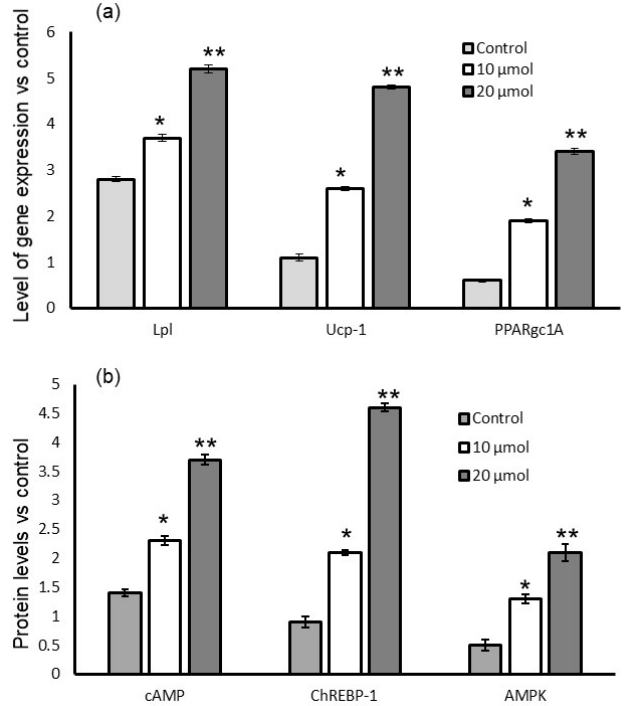
Figure 8. Effect of lut-7 -O- rutinoside on mRNA expression levels of Lpl, Ucp-1, and PPARGC-1A ( a ) and protein levels of cAMP, chREBP, and AMPK ( b ) in L6 myotubes. Each value is presented as the mean ± SD for 6 replicates. *: p ≤ 0.05 and **: p ≤ 0.001, lut-7 -O- rutinoside-treated L6 myotubes compared with control.